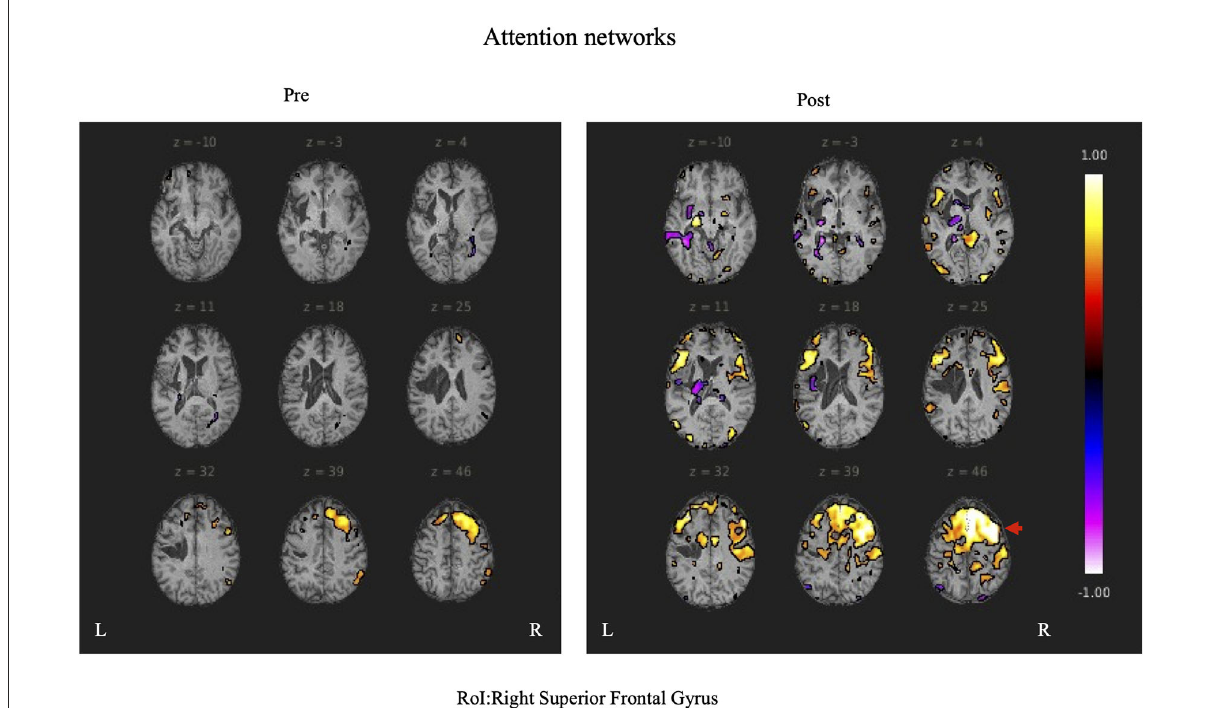
FIGURE5 The right superior temporal gyrus was set as the region of interest (ROI) and the results of Seed-to-Voxel are shown. Correlation coefficients of 0.5 or more and − 0.5 or less in each ROI are shown in color. The right frontal gyrus is indicated by red